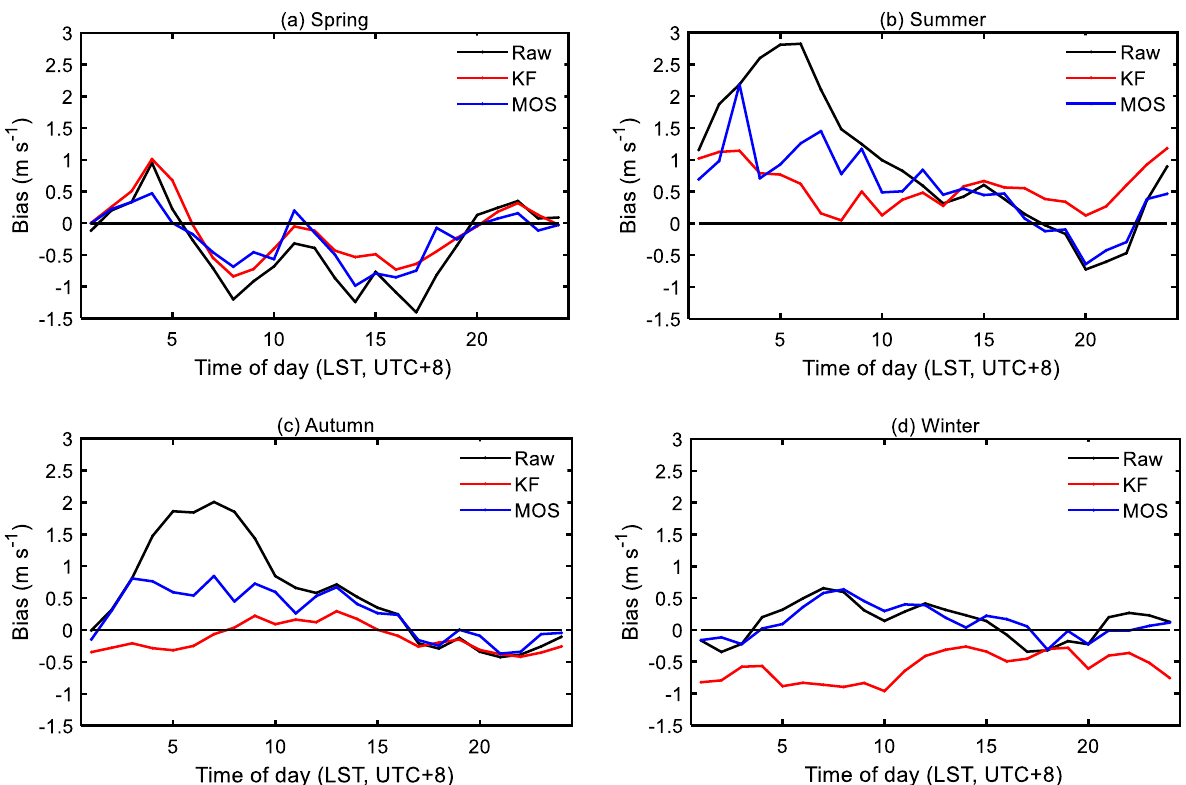
Fig. 3 Temporal evolution of bias in a spring, b summer, c autumn, d winter for the raw forecasts, and the KF and MOS bias corrections across the 24 h of